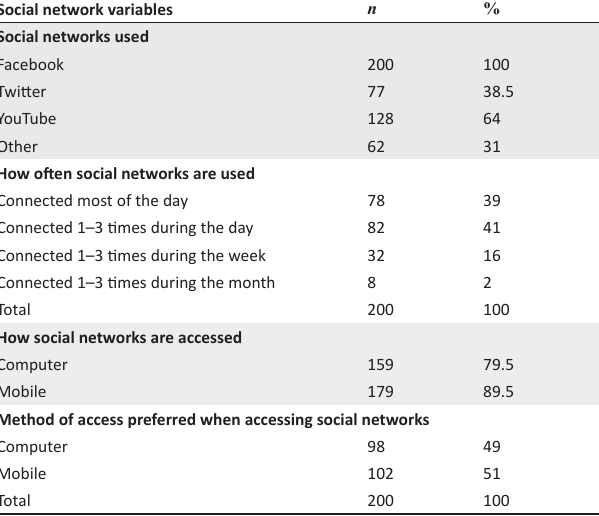
TABLE 1: Students’ access to social network